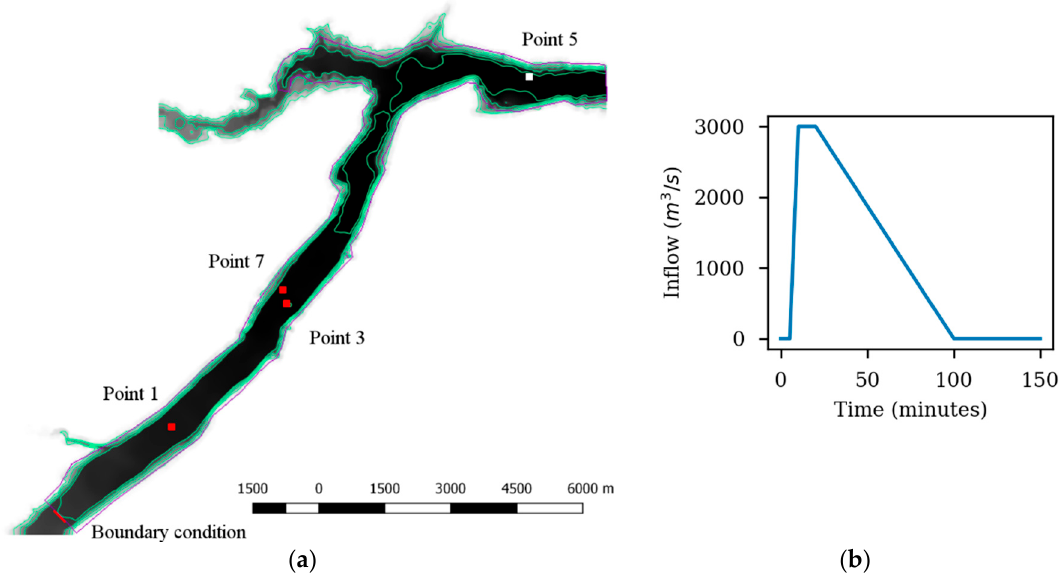
Figure 9. Setup of Test 5. ( a ) Shows the simulated domain. White areas represent higher elevations and black areas represent lower elevations. Light green lines are level curves. The inlet boundary condition is marked in red. The measurements were performed at the points shown above; ( b ) Hydrograph used as the upstream inlet boundary condition.